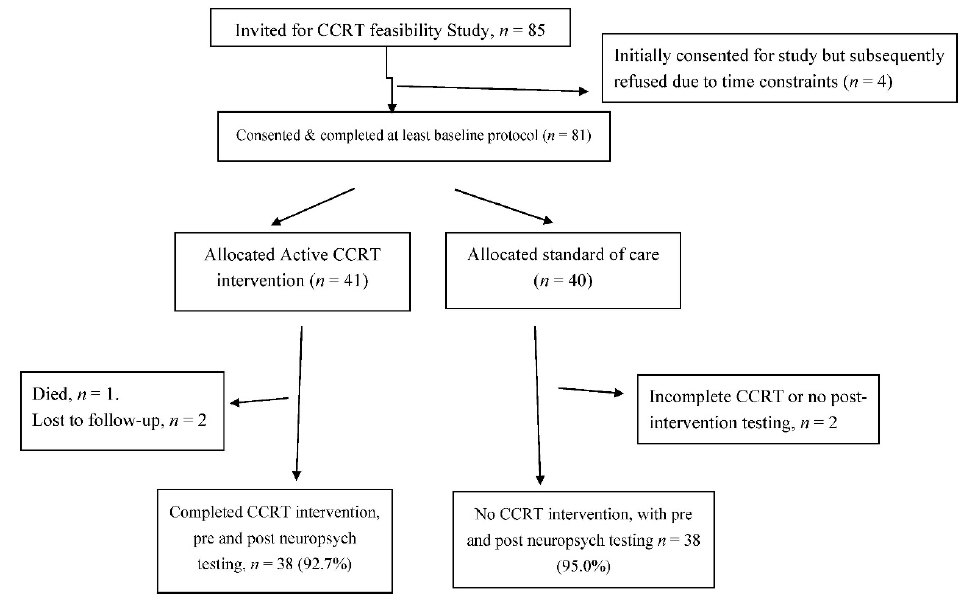
Figure 1. Sample selection to evaluate the feasibility and preliminary impact of Computerized Cognitive Rehabilitation Training on Performance Based Neurocognitive Function, Quality of Life and Frailty among Ugandan Adults 50 years and above, July 2017–October 2018. CCRT, computerized cognitive rehabilitation therapy.